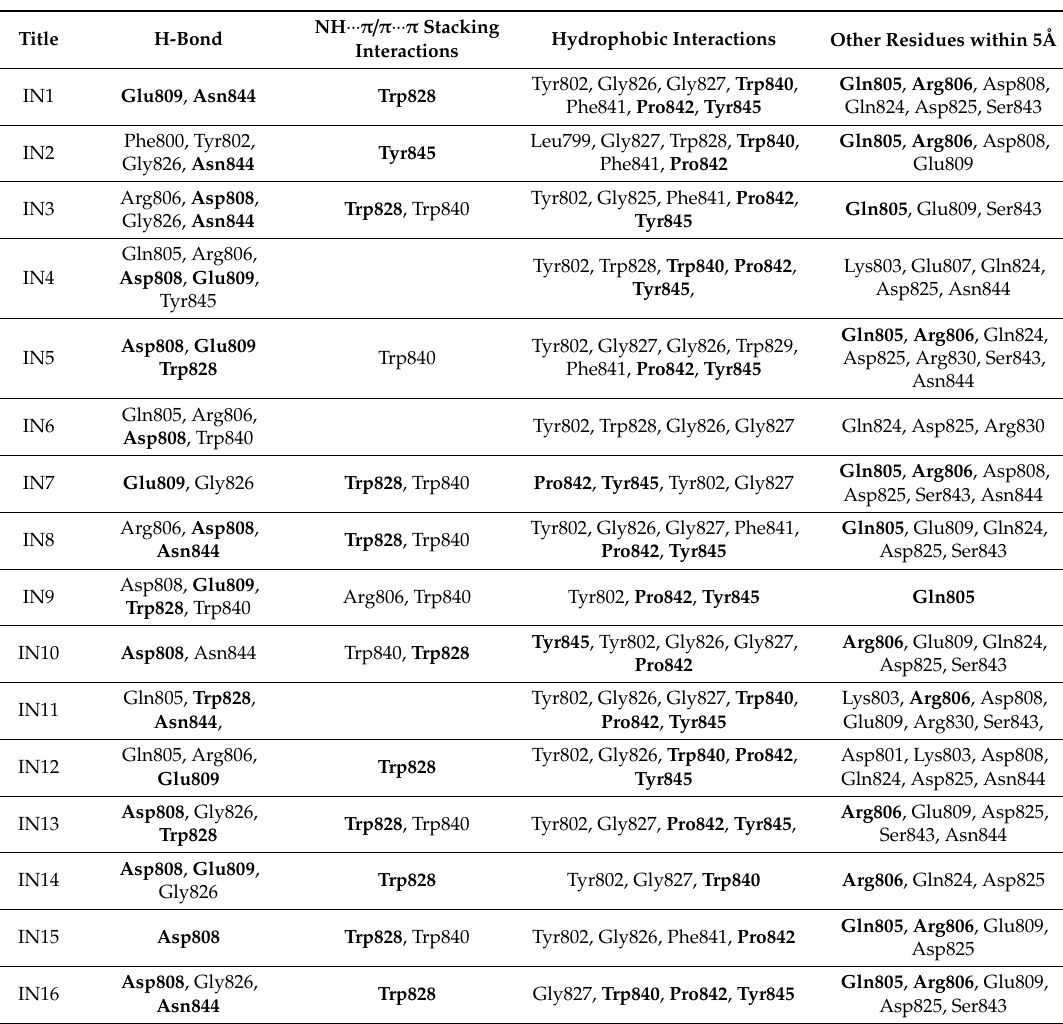
Table 1. Molecular recognition interactions between IN1-IN16 molecules and PLC γ 1 after induced fit molecular docking. Residues in bold are also involved in similar interactions with